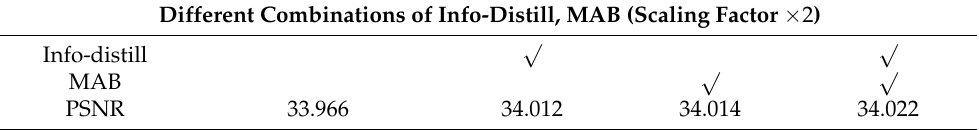
Table 3. The quantitative results of each module. The best PSNR (dB) results on the validation set after 2 × 10 5